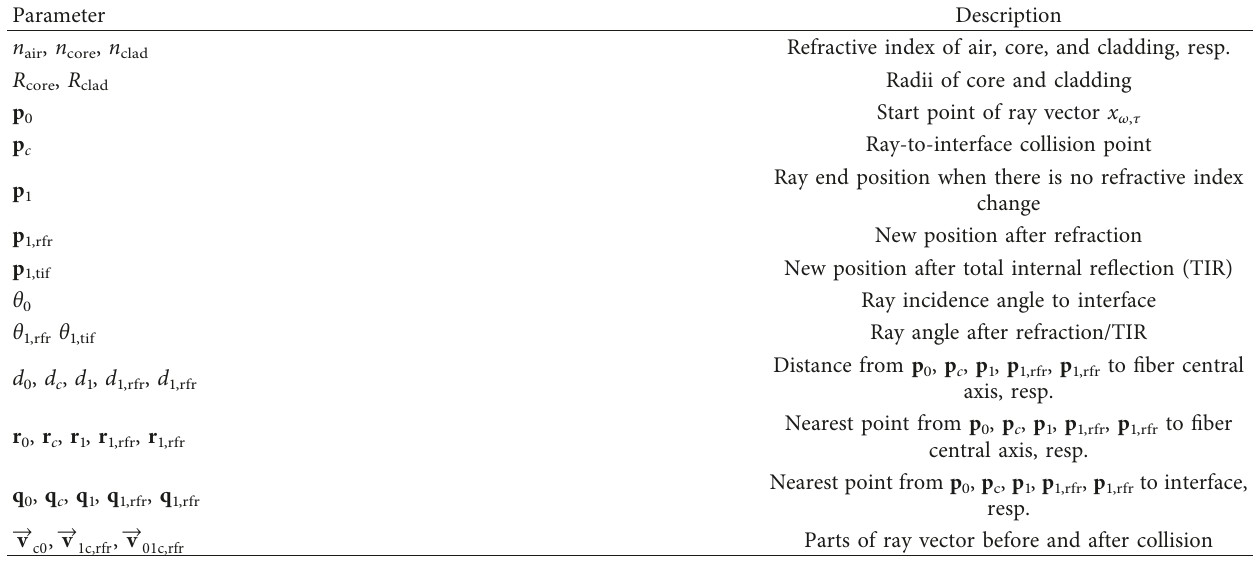
Table 3: Detailed description of the parameters in Figure